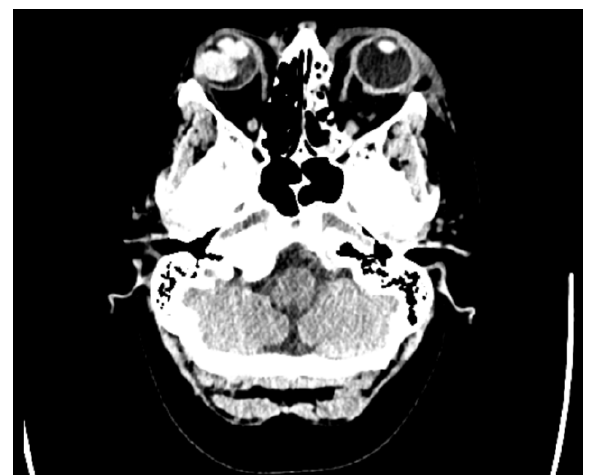
Figure 1: Computerised tomography of the head without contrast revealing a right hyperdense orbital mass, fracture of the left orbit with opacification of adjacent ethmoid air cells, air-fluid level in the left maxillary sinus, and subcutaneous emphysema with bruising overlying the left orbital region The patient was reviewed in the clinic where direct fundo- scopy by the ophthalmologist visualised a layer of silicone oil and this corresponded with the imaging